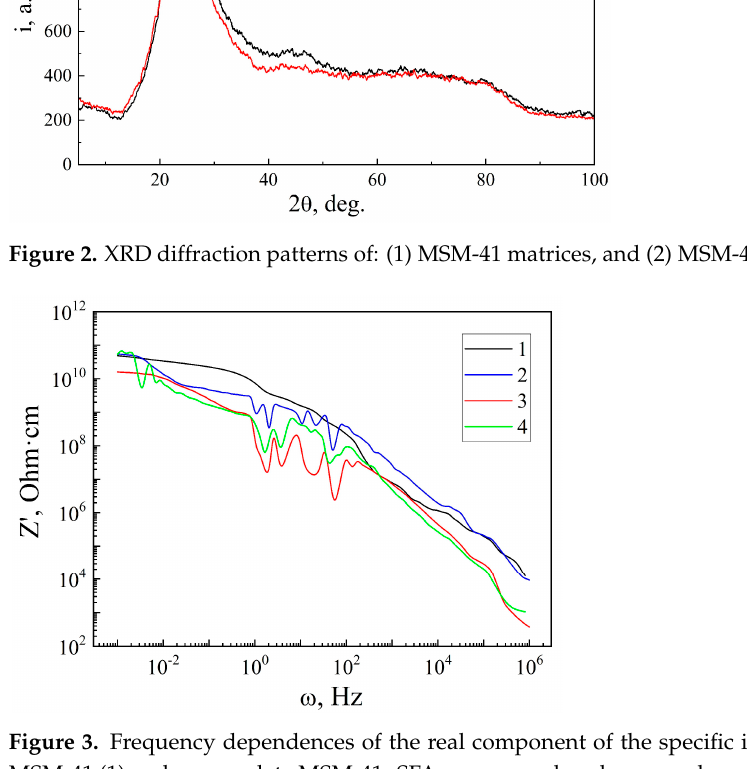
Figure 3. Frequency dependences of the real component of the specific impedance of the matrix MSM-41 (1) and encapsulate MSM-41<SFA>, measured under normal conditions (2), in a magnetic field (3), and under illumination (4).